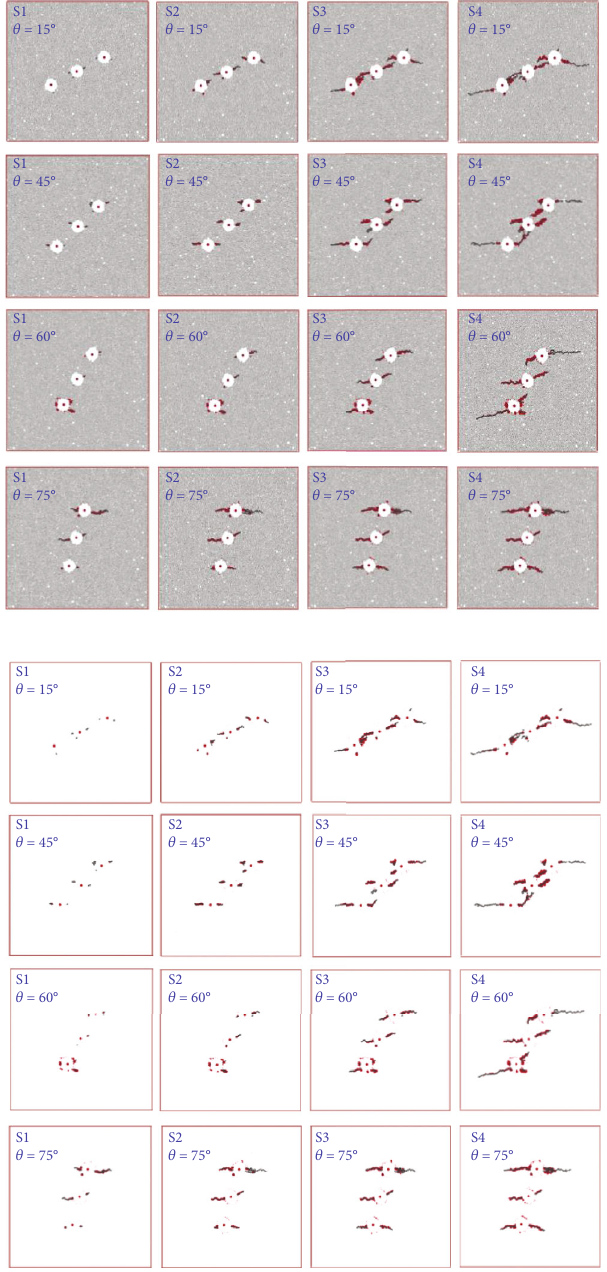
Figure 13: Initiation and propagation process of directional hydraulic fractures at di ff erent angles between the direction of borehole line and maximum principle stress σ 1